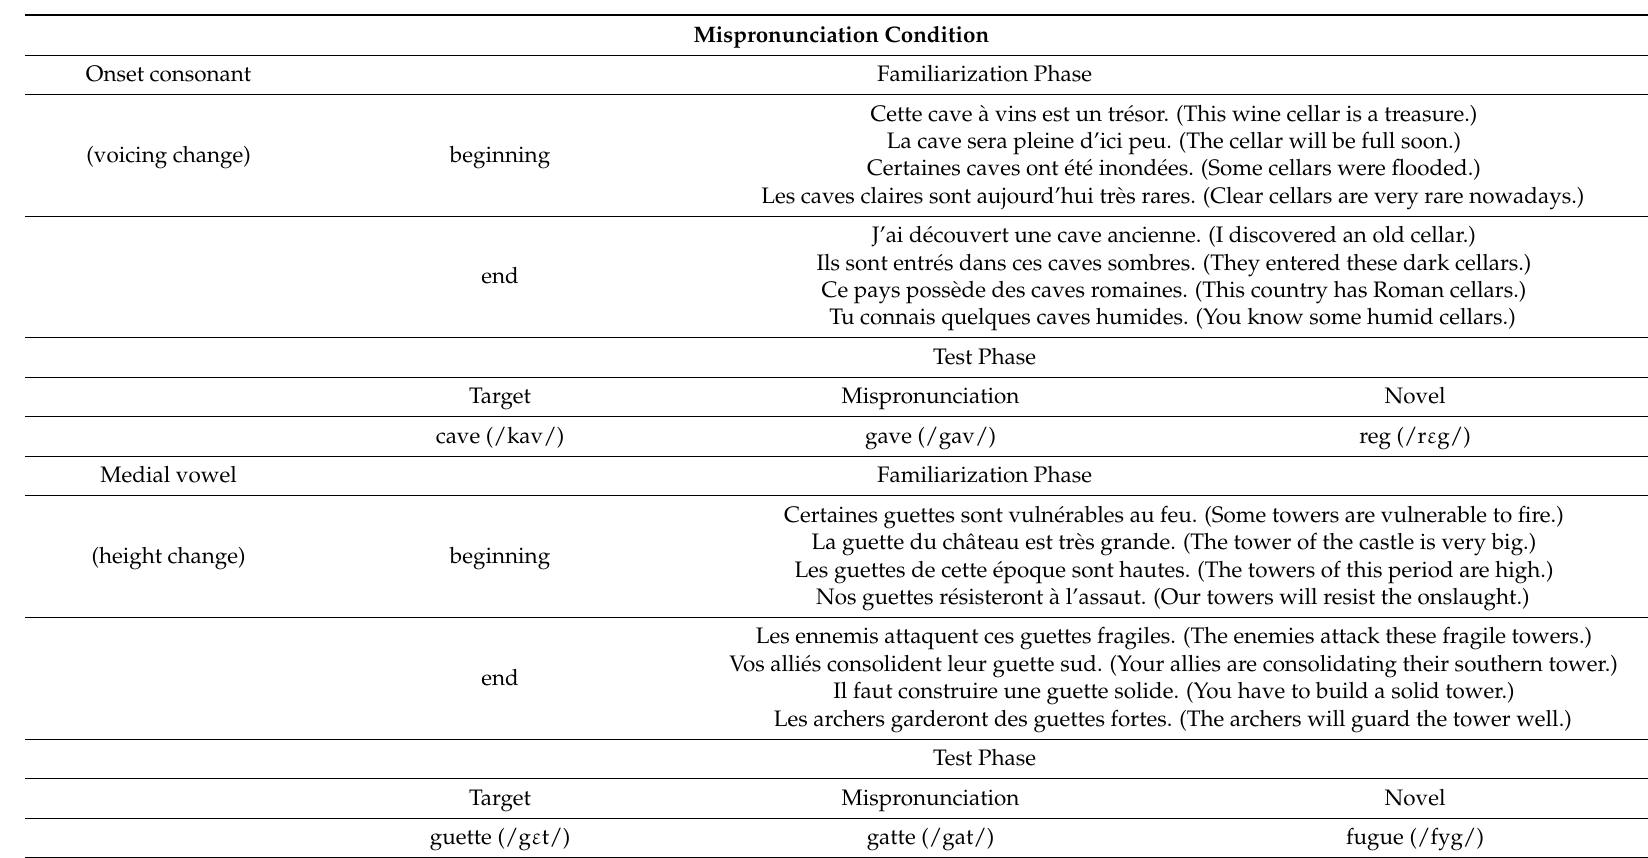
Table 1. A table of stimuli examples given separately for each of the three types of mispronunciations (onset consonant, medial vowel, coda consonant). Although there were three types of feature changed for consonant (voicing, place, and manner) and vowel (height, place, and roundness) mispronunciations, we give one example of feature change for each mispronunciation type. For the familiarization phase, four sentences contained the target word positioned towards the beginning and four contained the target word position towards the end. English translations of the sentences are provided in parenthesis. For the test phase, the isolated words were presented three times each. Their IPA (International Phonetic Alphabet) transcriptions are given in